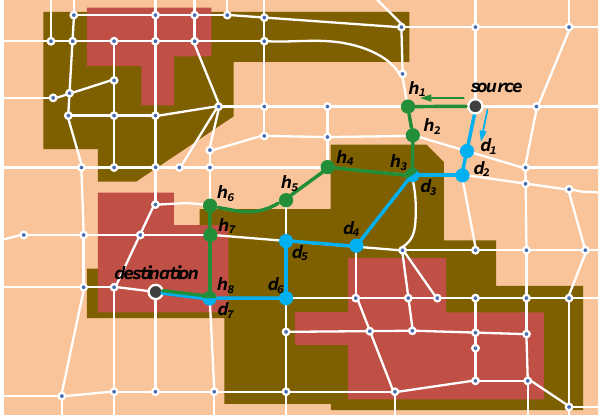
Figure 6. Heuristic search and Dijkstra breadth-first search path